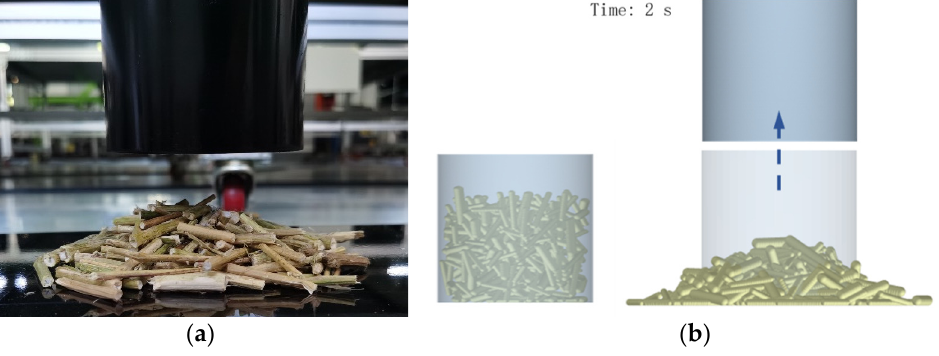
Figure 5. Rape stem repose angle test. ( a ) Physical test; ( b ) Simulation test.